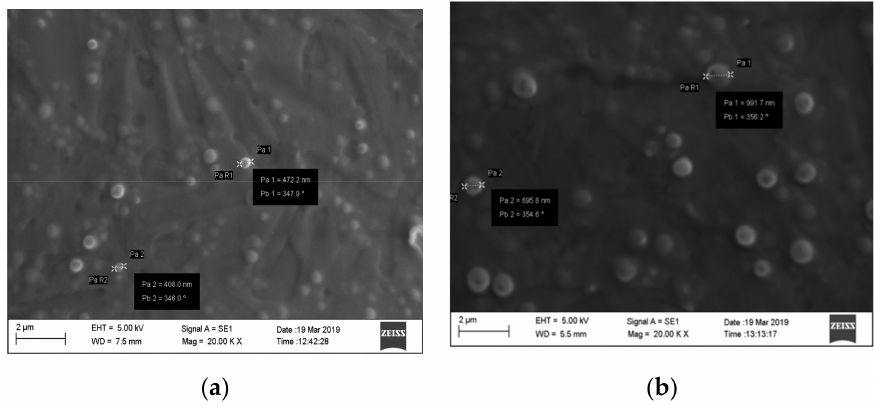
Figure 1. ( a , b ) SEM images of NP3 and NP8 at 20,000 ×